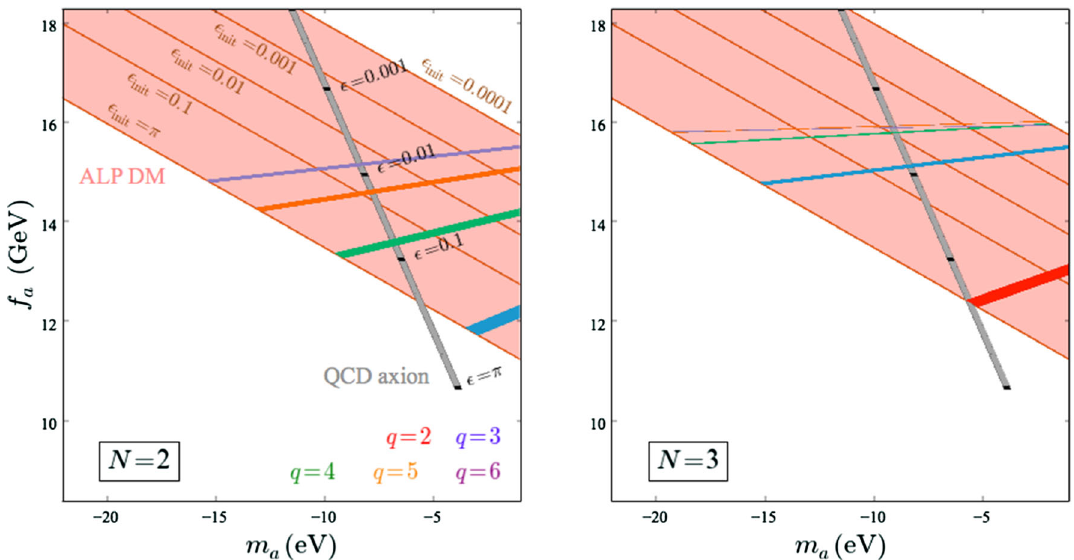
axions are found in our model. The QCD axion parameter space is given by the grey line. Axes are log-scale)